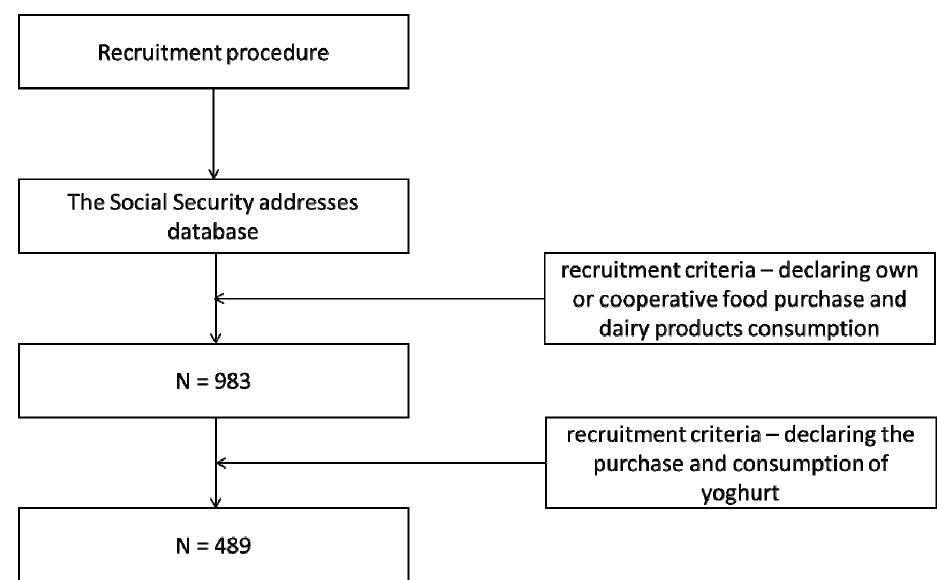
Figure 1. Participants’ inclusion in the study.